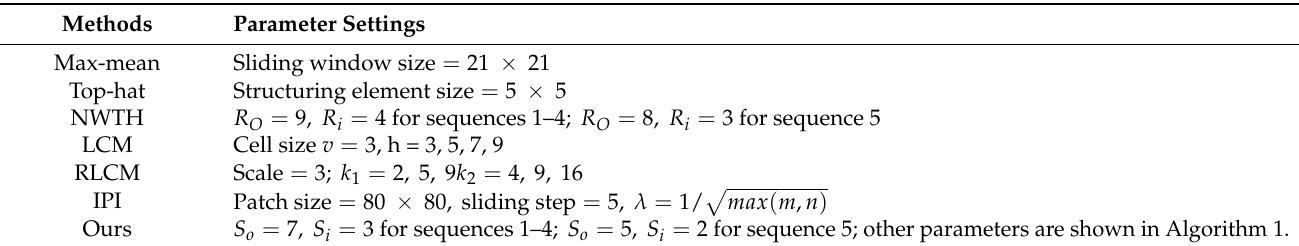
Table 2. The parameters of the comparison